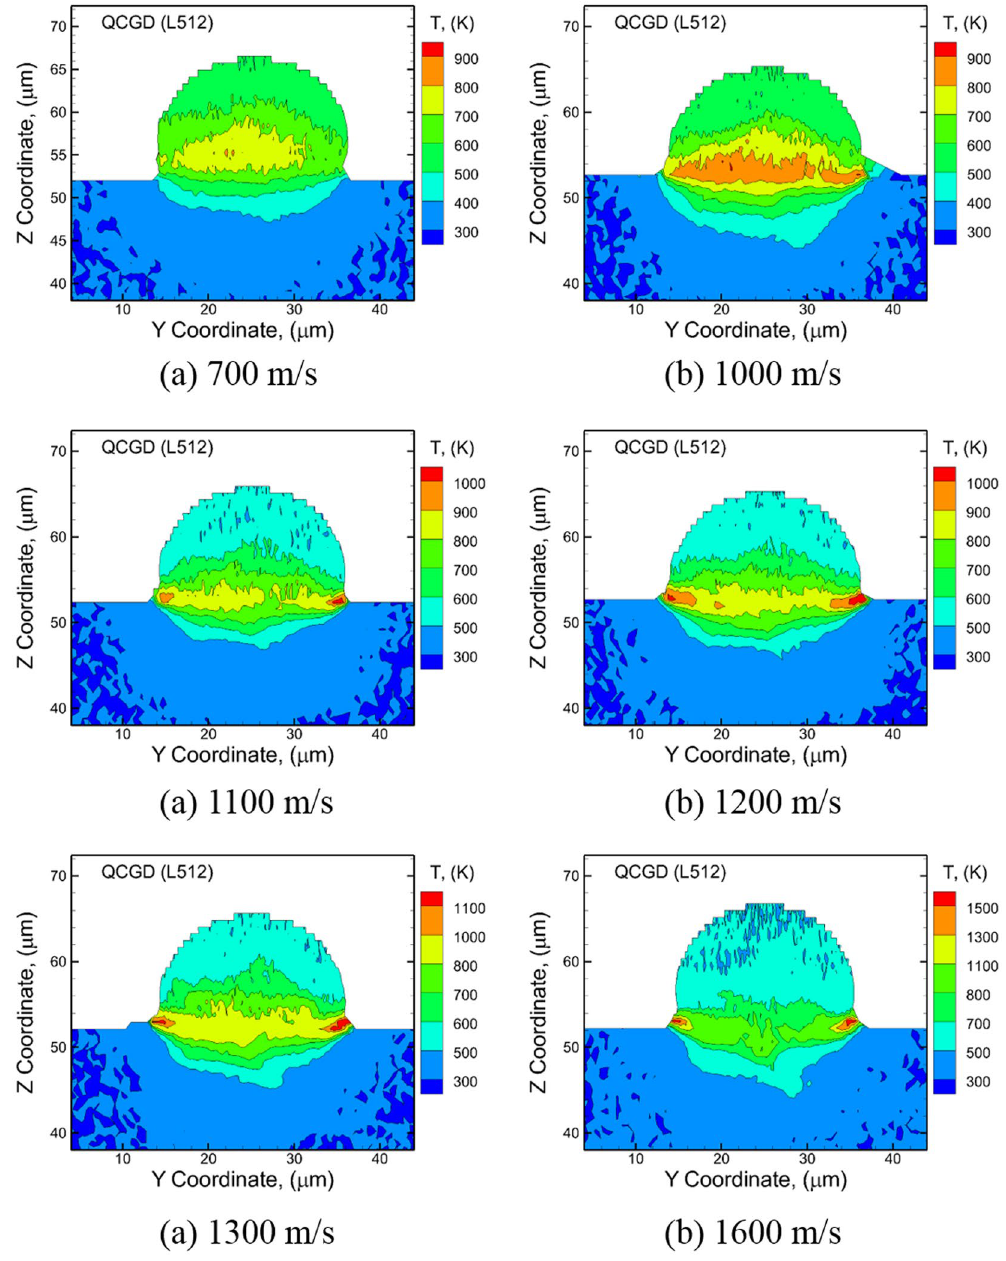
Figure 7. Snapshots at the time that showed the maximum temperature during the course of a full simulation for the cases of impact velocities of ( a ) 700 m/s, ( b ) 1000 m/s, ( c ) 1100 m/s, ( d ) 1200 m/s, ( e ) 1300 m/s and ( f ) 1600